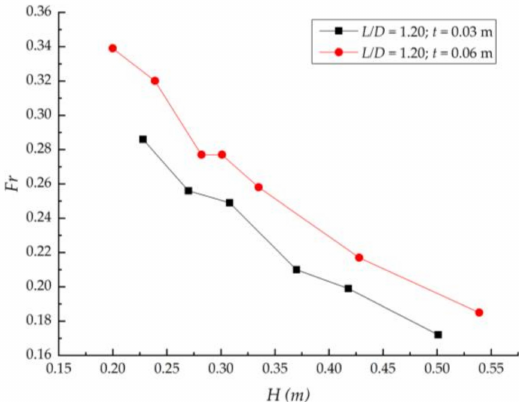
Figure 6. Relationship between critical Fr and H for di ff erent ice thicknesses.